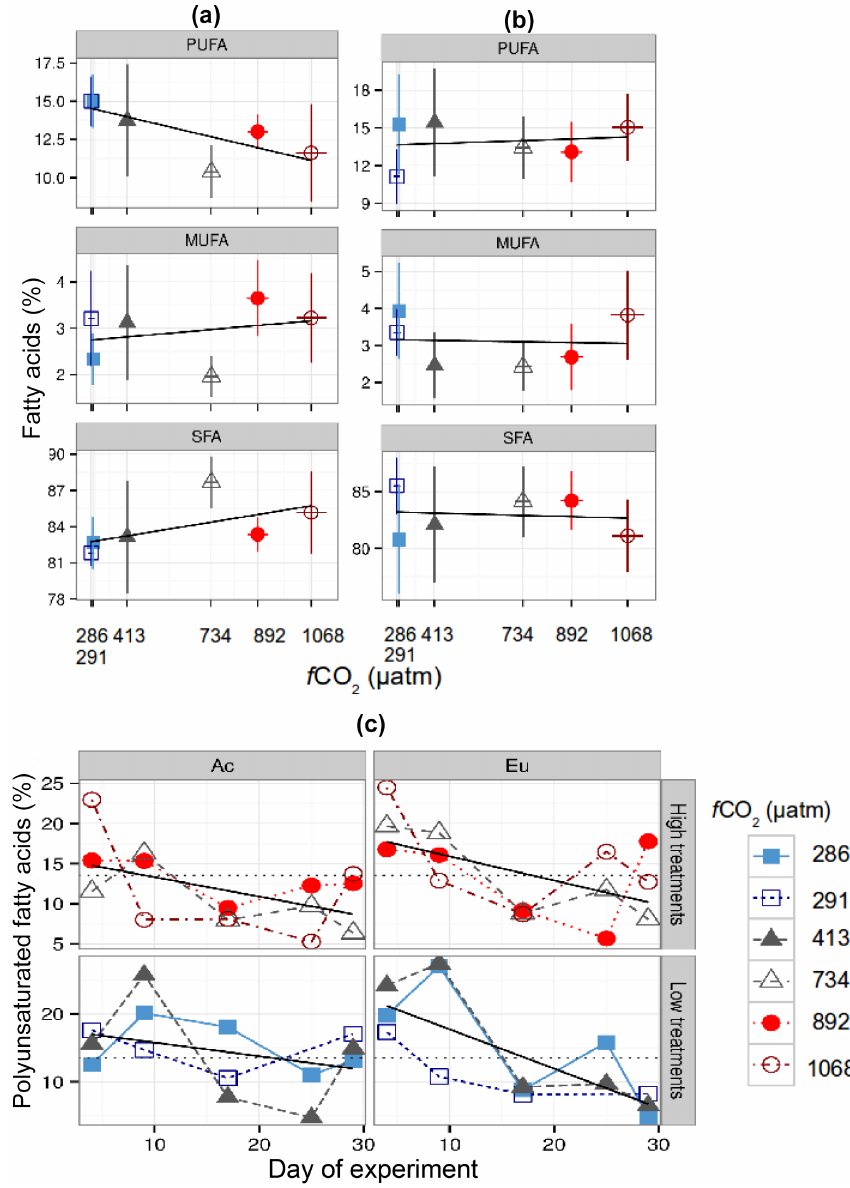
Figure 5. Panels (a) and (b) show the relative polyunsaturated (PUFA), monounsaturated (MUFA) and saturated (SFA) fatty acid content in the copepods Acartia bifilosa and Eurytemora affinis , respectively, under the f CO 2 gradient treatments between days 1 and 29. The x axes show the mean f CO 2 measured during the sampling period, bars shows standard error. (c) Relative PUFA composition of Acartia bifilosa (Ac) and Eurytemora affinis (Eu) over time in the 876, 1012 and 1314µatm f CO 2 levels (high CO 2 treatments) and the 362, 403 and 590µatm f CO 2 levels (low CO 2 treatments). Horizontal dashed line indicates the position of the overall mean PUFA